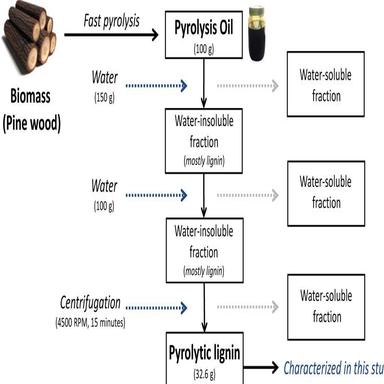
Water fractionation of pyrolysis oil to yield the PL fraction for characterization.